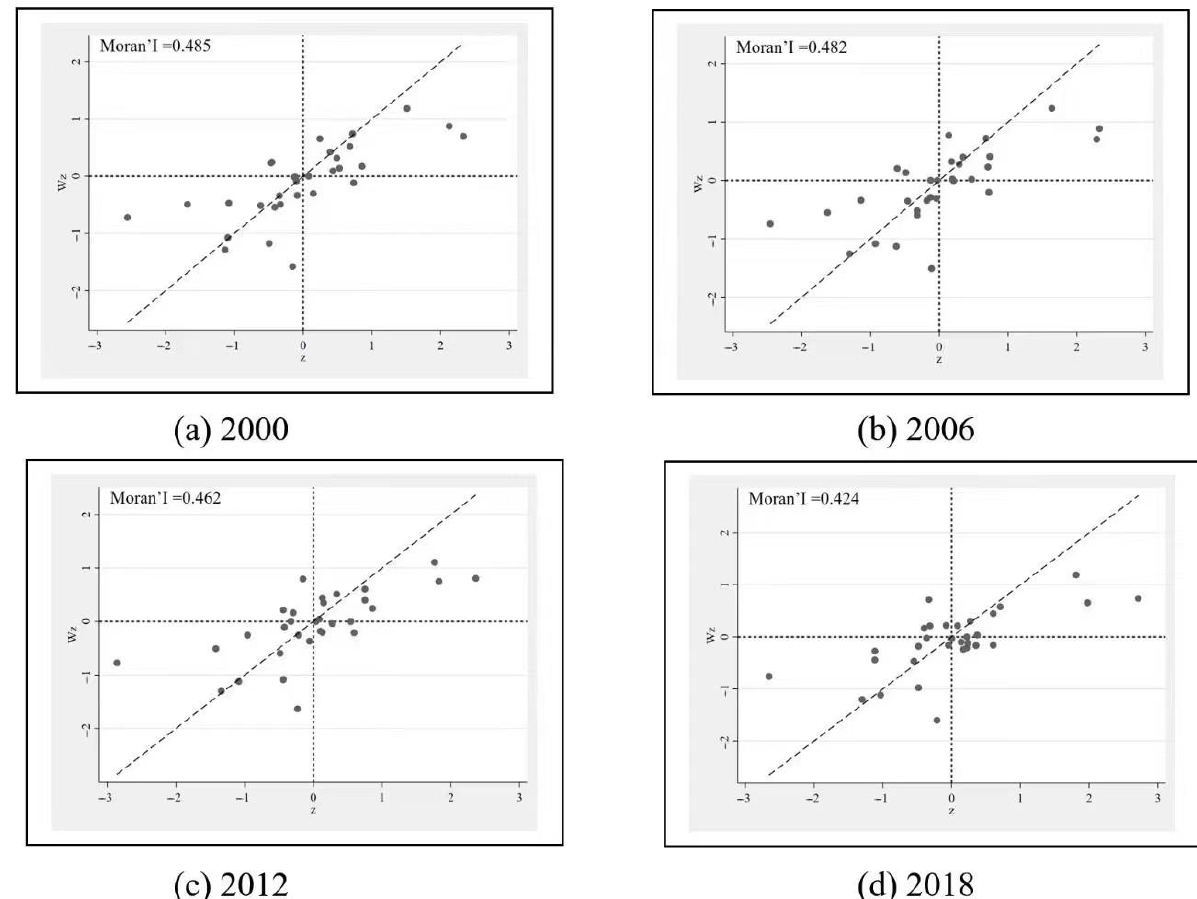
Figure 5. Scatter plot of Moran ’ s I in HDI. Table 2. Estimation Results of the Spatial Spillover Effect of HDI.